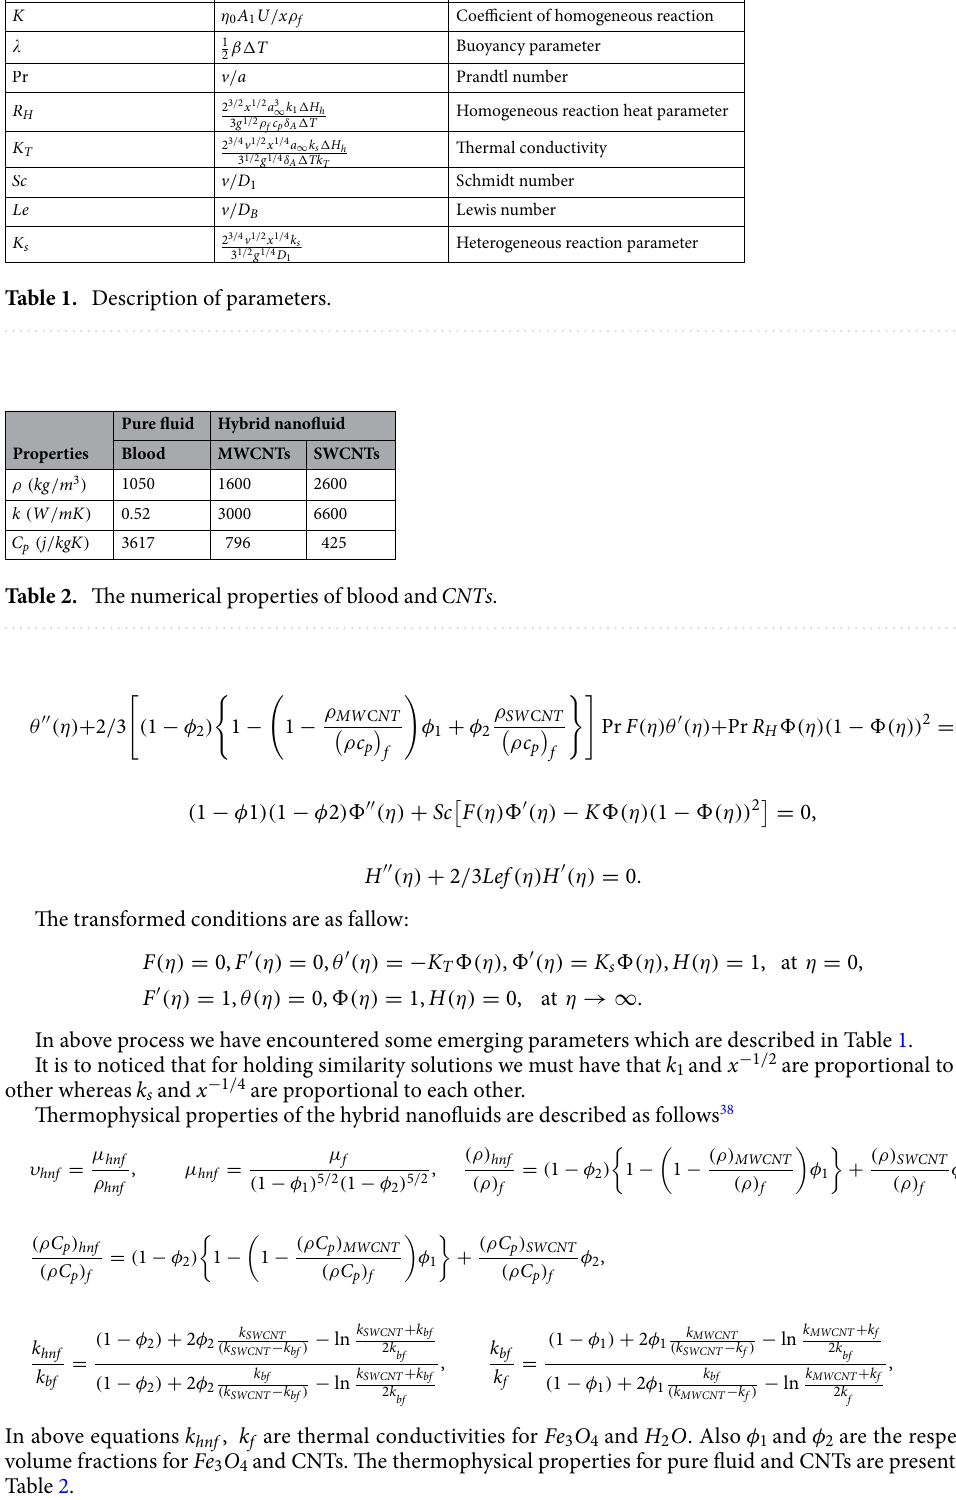
fx and local Nusselt number Nu x , Sherwood